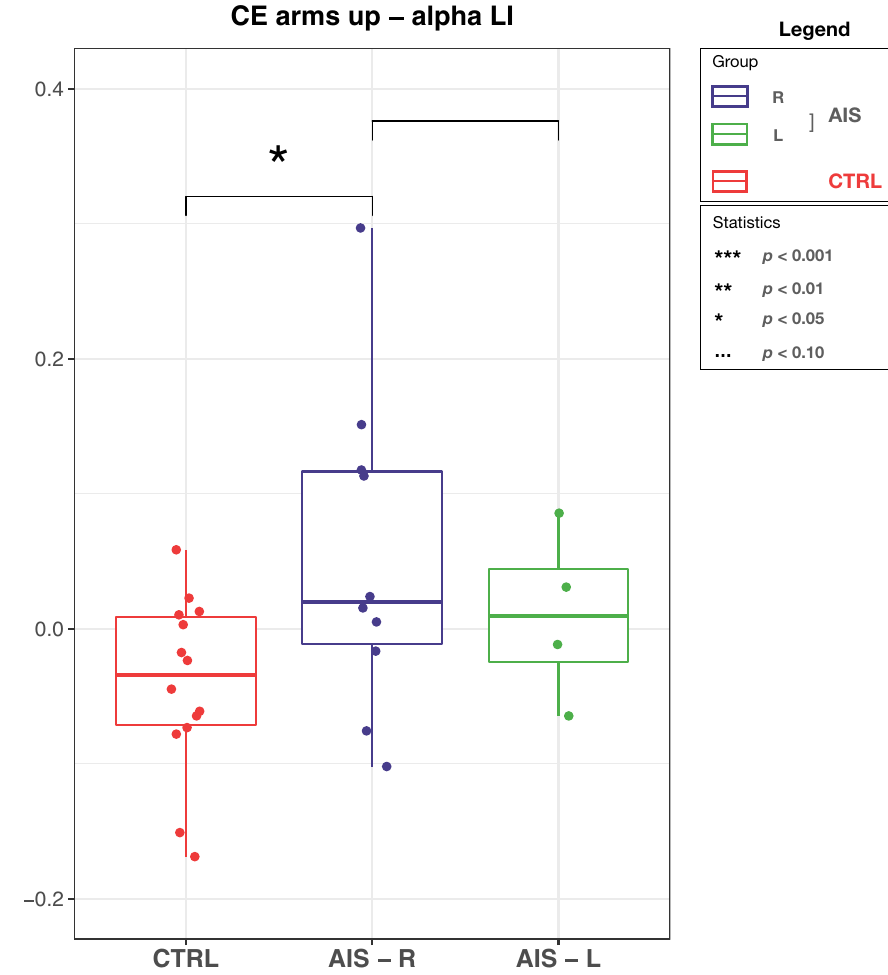
Figure 3. Grand-average LI in alpha band during CE arms up for controls (CTRL), adolescents with AIS with right main curve (AIS-R) and adolescents with AIS with left main curve (AIS-L). On each box, the central red line indicates the median, and the bottom and top edges of the box indicate the 25th and 75th percentiles, respectively. The whiskers extend to the most extreme data points not considered outliers, and the outliers are plotted individually using the ‘+’ symbol. Significant difference ( p < 0.05 ) was observed between CTRL and